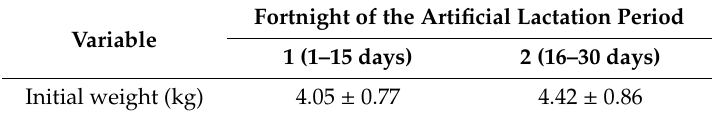
Table 9. Influence of the initial weight on the fortnight of the artificial lactation period in which the lambs died.